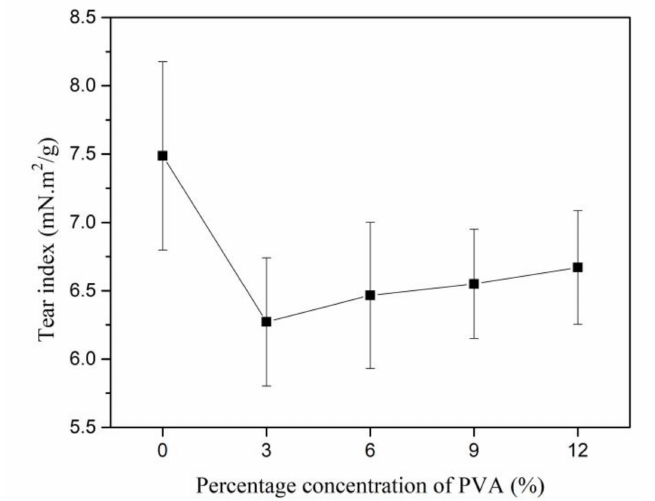
Figure 20. Tear index at di ff erent weight percentage concentration of PVA.